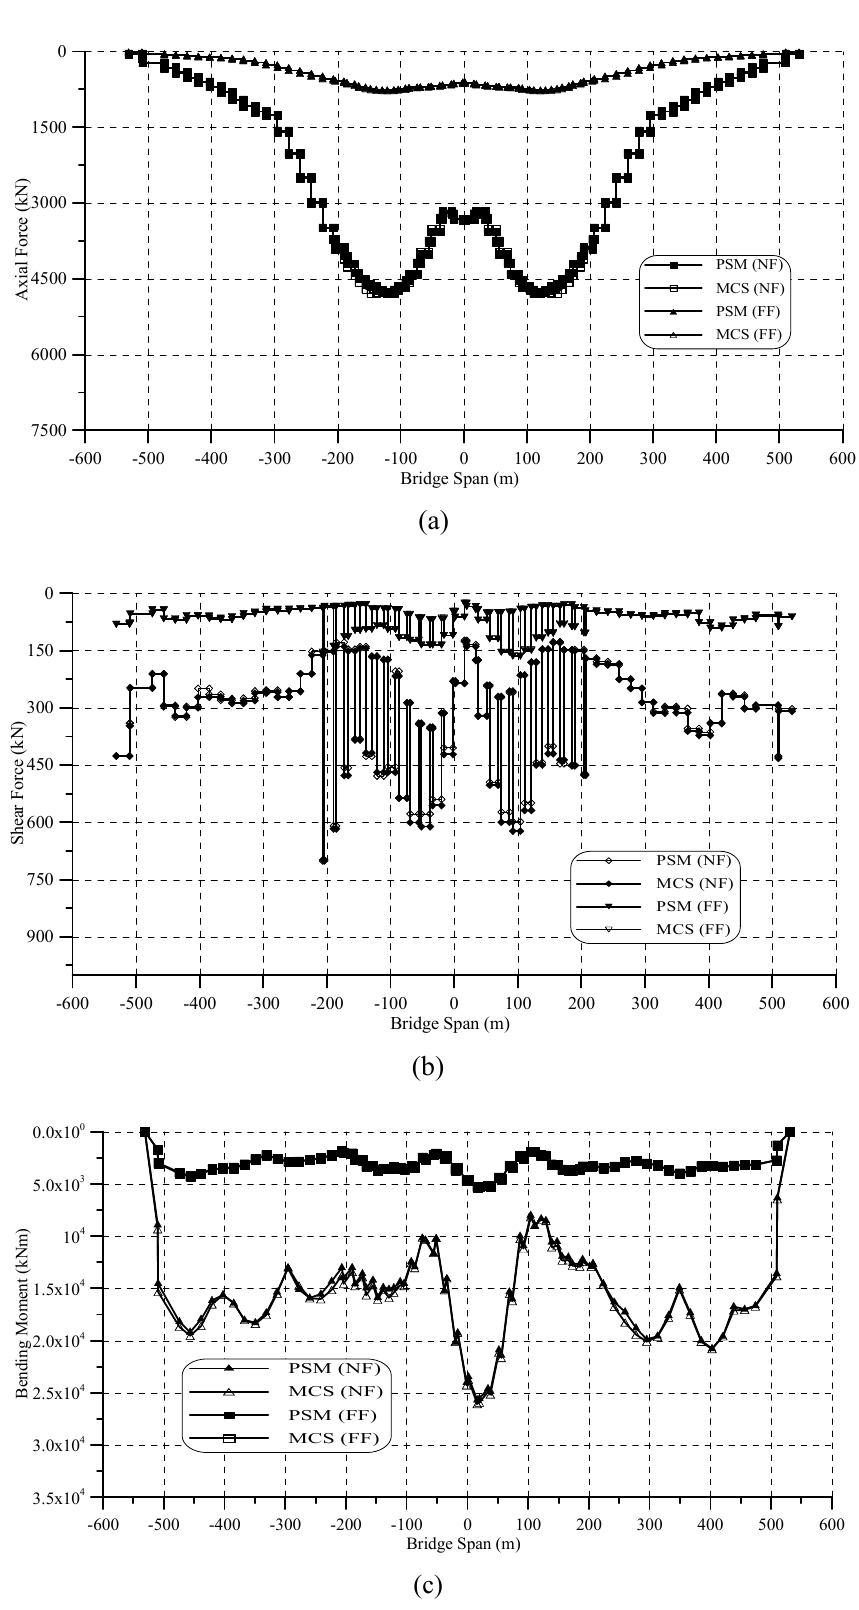
Fig.9. Maximum sensitivity axial forces (a), shear forces (b) and bending moment (c) for deck of Bosporus Bridge for random elastic module (E).